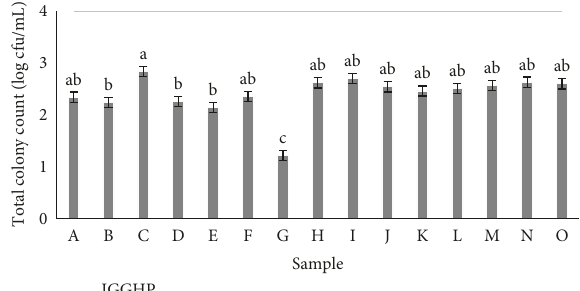
Figure 6: Total colony count at 37 ° C for 15 samples of treated water. A-B: Sg. Ramal ; C-E: Section 8, Bandar Baru Bangi ; F-I: Section 16, Bandar Baru Bangi ; J, K, and O Section 3, Bandar Baru Bangi ; L-N: Section 15, Bandar Baru Bangi . All results are expressed in mean ± SD. a-c Values for the samples which have different letters are significantly different ( p < 0 . 05).